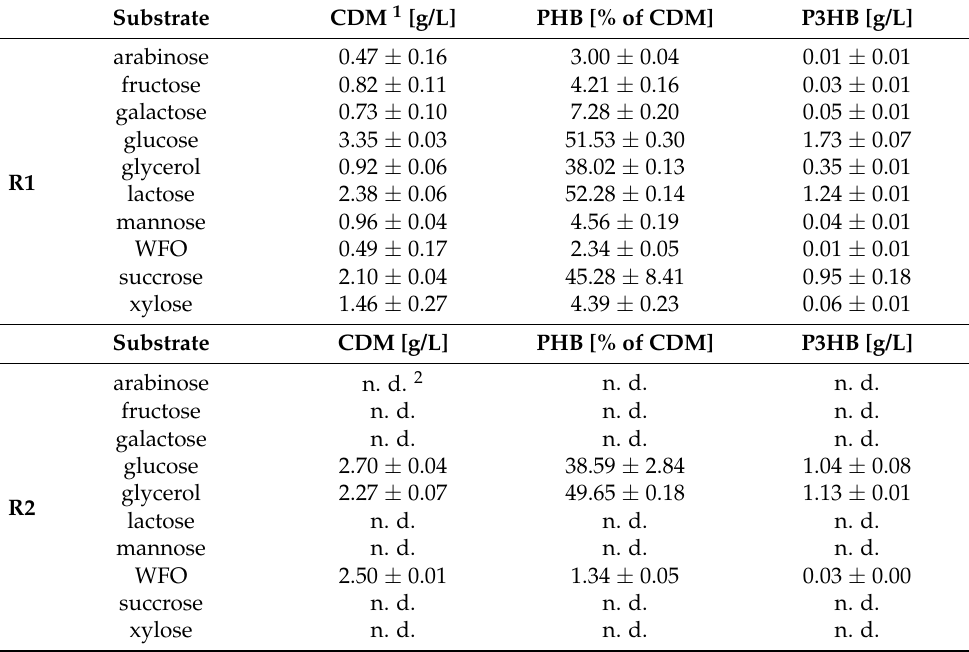
Table 3. The ability to utilize various carbon substrates for growth and PHA synthesis by bacteria R. xylanophilus (R1) and R. spartanus (R2)